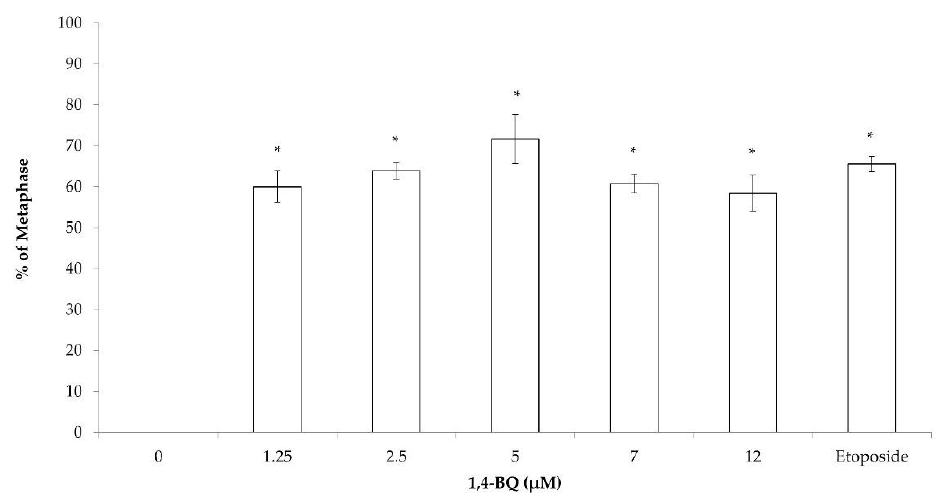
Figure 5. CA of myeloid progenitor cells harvested after 14 days of CFC assay following pre-exposure of MBMCs to 1,4-BQ for 24 h. Twenty metaphases were scored for each experimental group and the percentage of CA is as presented. Data are presented as the mean ± S.E.M. ( n = 3) and analyzed by using one-way ANOVA. * p < 0.05 compared with the negative control group.